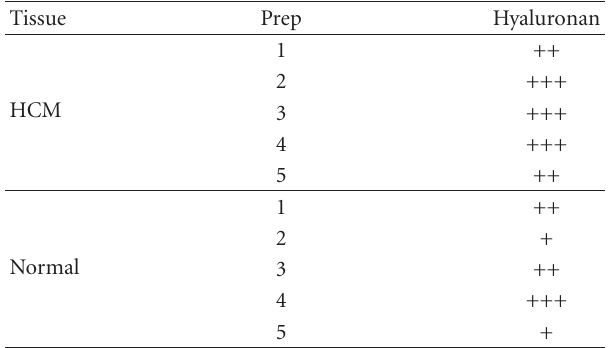
Table 2: The HABP-stained sections were evaluated and the staining intensity was recorded using a three-graded scale: +: weak, ++: moderate, and +++: